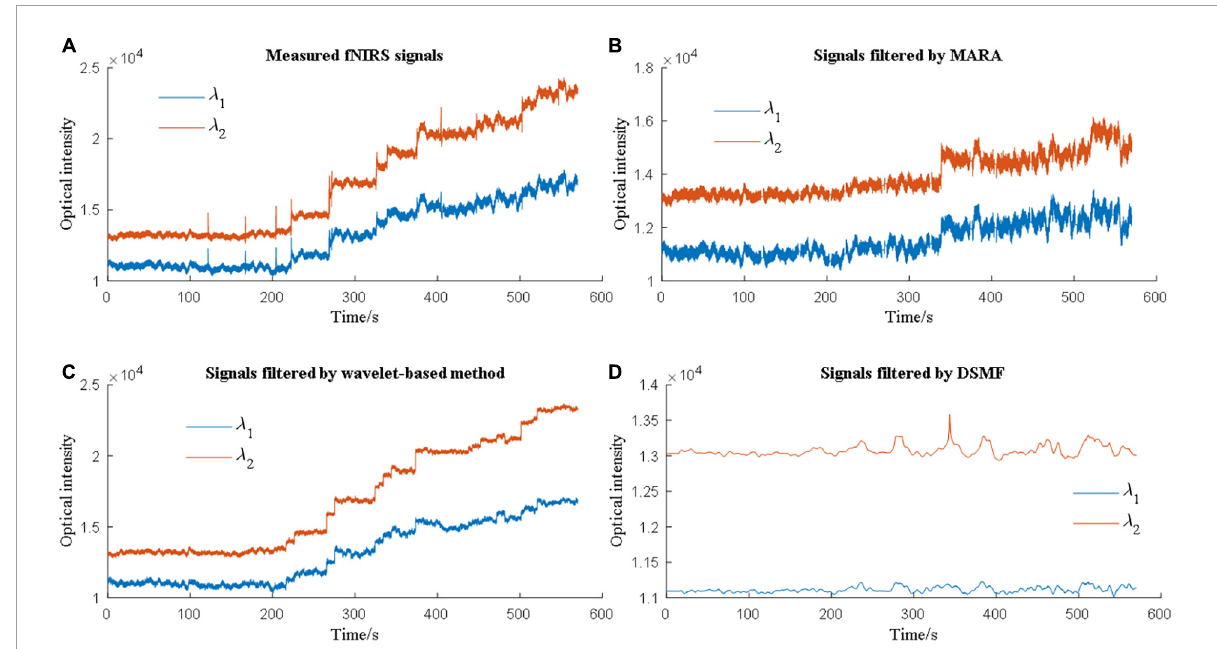
FIGURE5 Different motion artifact (MA) removal techniques have different performances when processing experimental